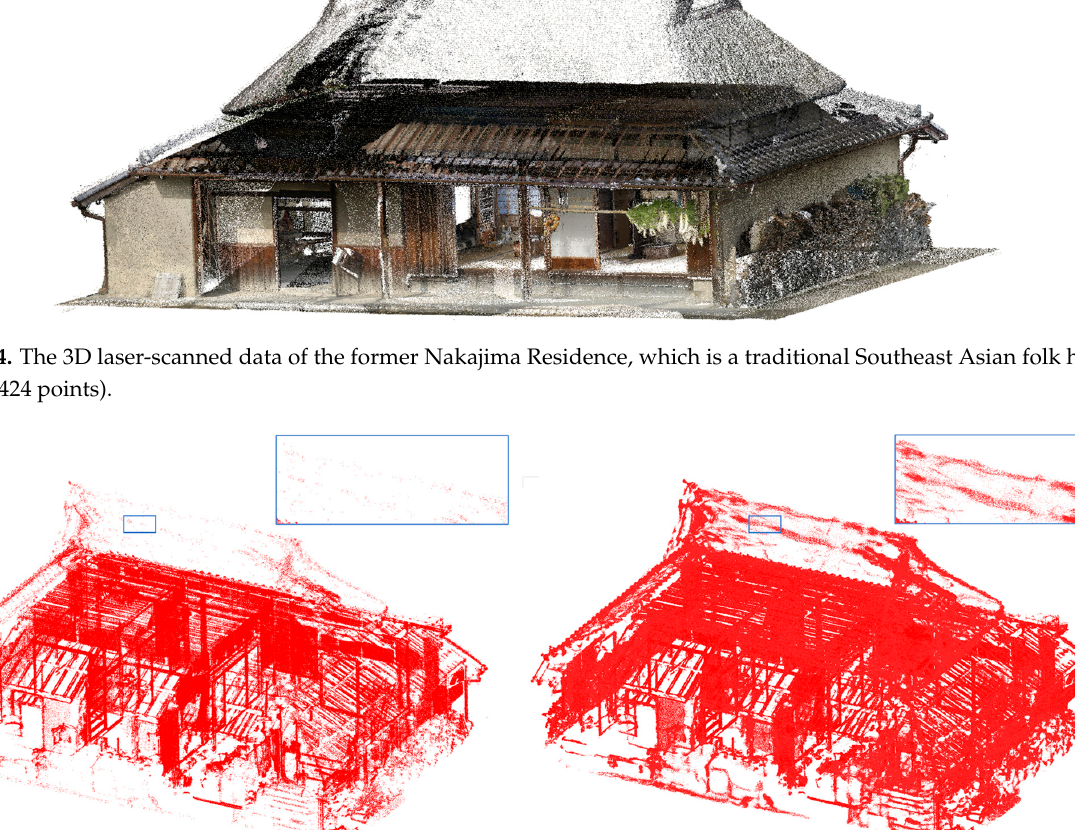
as the 3D-edge regions. The threshold th